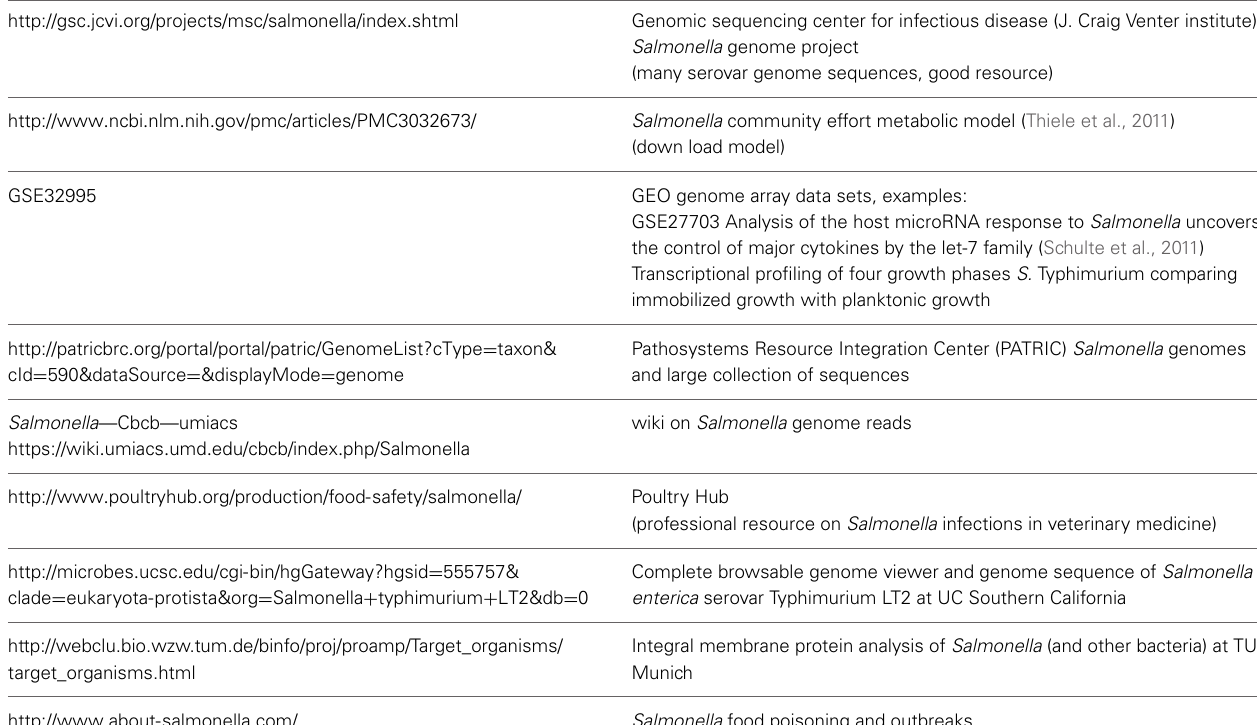
Table 1 | Useful WEB resources for Salmonella